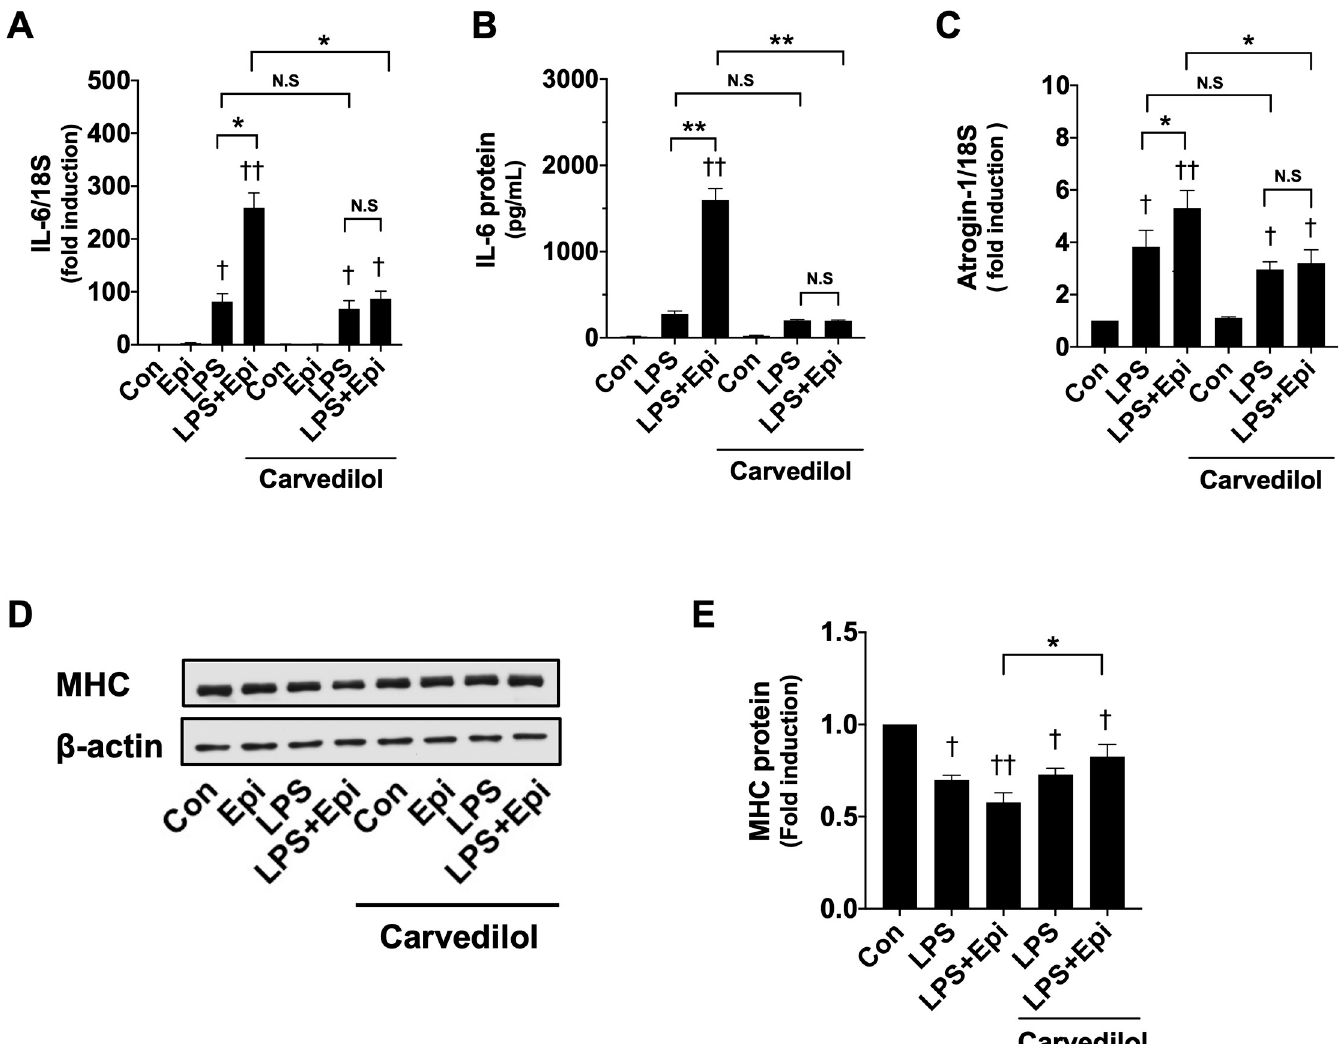
Fig 8. A β -blocker inhibited the effect of Epi in C2C12 myotubes. (A, B, C) C2C12 myotubes were pretreated with the β -blocker Carvedilol (5 μ M) for 30 min, and were then exposed to Epi (1 μ M) and/or LPS (50 ng/ml) for 3 h. IL-6 (A) and Atrogin-1 (C) mRNA were analyzed with qRT-PCR, and their expression levels, normalized to the 18S rRNA expression level, are presented as mean ± SEM (n = 3) of fold induction relative to the value of the control condition. The IL-6 concentrations in the conditioned media were analyzed with the ELISA assay, and are presented as mean ± SEM (n = 3–4) (B). (D, E) After pretreatment with Carvedilol (5 μ M) for 30 min, C2C12 myotubes were exposed to Epi (1 μ M) and/or LPS (50 ng/ml) for 24 h. Whole-cell lysates were analyzed for MHC and β -actin protein expression by immunoblotting assays, and a representative immunoblot is shown (D). MHC protein expressions, quantified by densitometric analysis, were normalized to the expression level of β -actins, and fold induction relative to the control condition is presented as mean ± SEM (n = 5) (E). (†P < 0.05 and ††P < 0.005 compared with control, � P < 0.05 and �� P < 0.005 for comparisons between the indicated